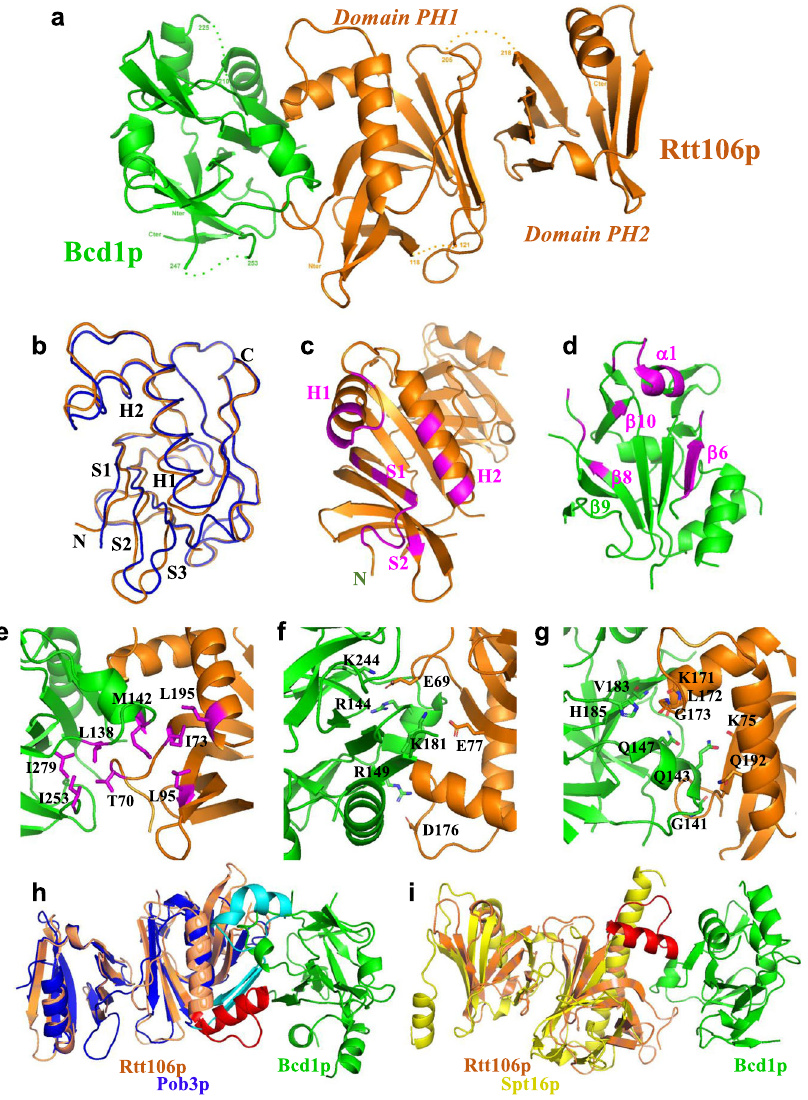
Fig. 6 Bcd1p 120-303 interacts with the PH1 domain of Rtt106p 65-301 . a Ribbon representation of the crystal structure of the complex between Rtt106p 65-301 and Bcd1p 120-303 . Rtt106p is in orange and Bcd1p in green. b Superimposition of the PH1 domain of Rtt106p bound to Bcd1p (in orange) and in a free state (in blue, entry PDB code 3TW1 22 [https://www.rcsb.org/structure/3TW1]). H = Helix, S = Strand, N = N-terminal extremity, C = C-terminal